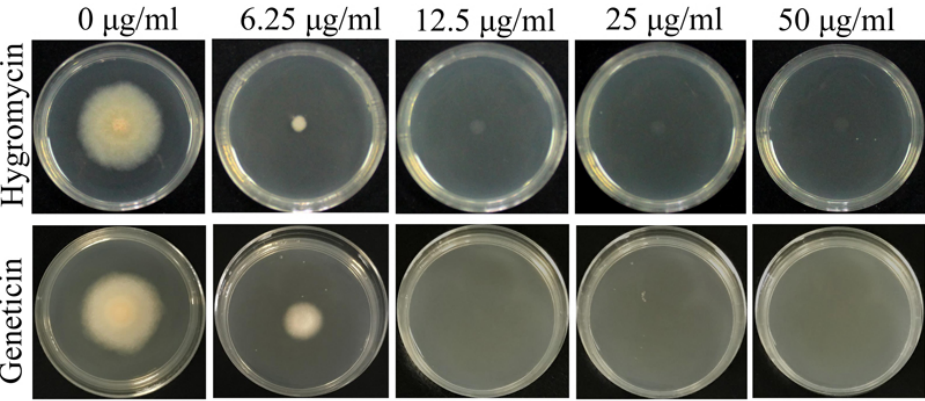
Figure 2. The sensitivity of F. venenatum TB01 to hygromycin and geneticin. Both antibiotics showed complete inhibition of F. venenatum TB01 at more than 12.5 µ g/mL.